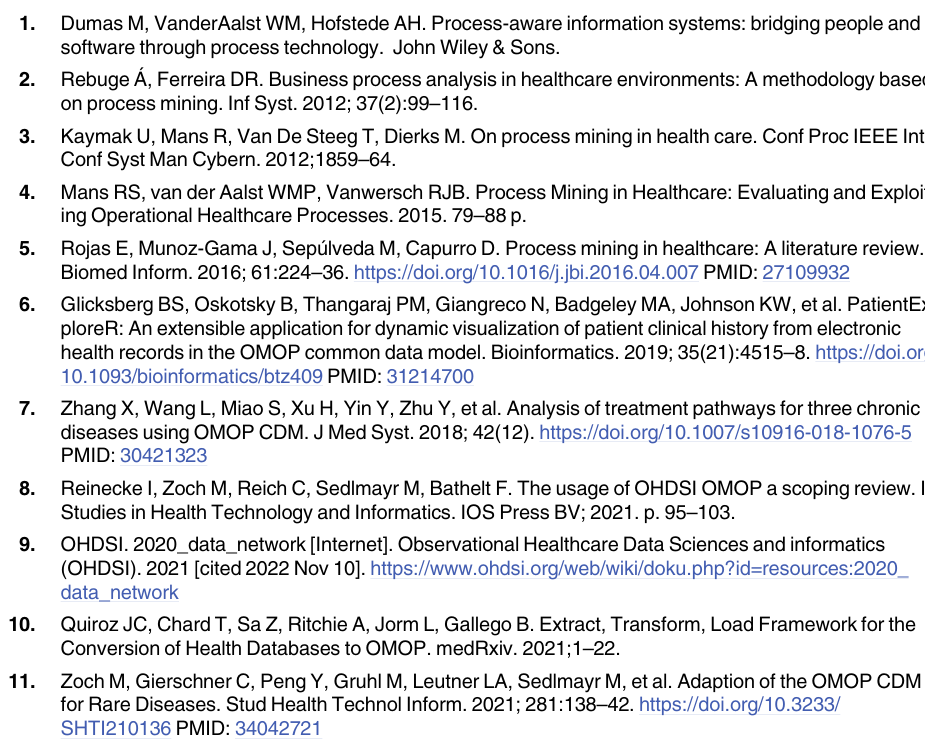
S1 Table. The query for event log formulation. S1 Fig. Enlarged view of Fig